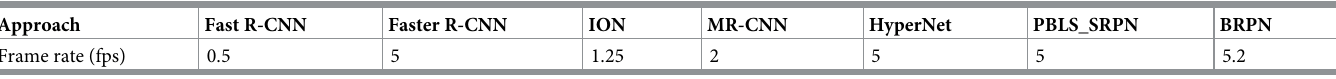
Table 13. Detection frame rate of the different methods on the PASCAL VOC 2007 test